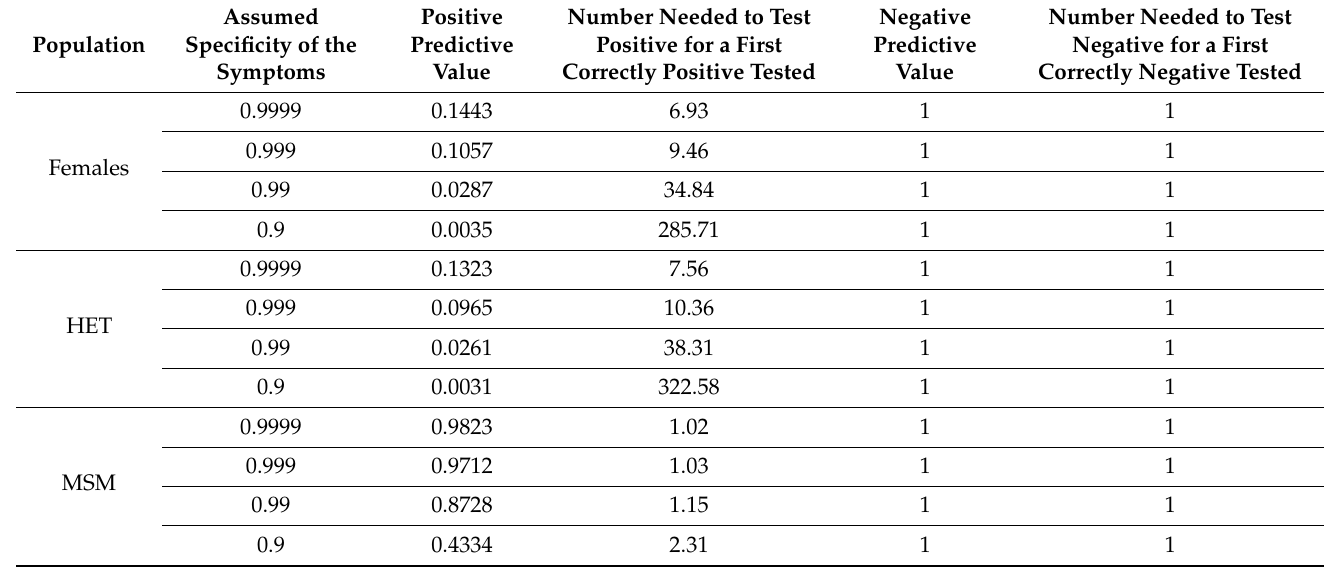
Table 6. Positive and negative predictive values for a combined case definition including both symptoms and Ag/Ab RDT results.